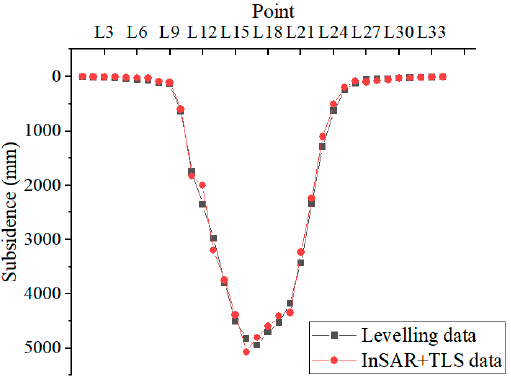
Figure 16. Comparison of levelling monitoring results and data fusion monitoring results. Table 7. Comparison of maximum subsidence values monitored by level data and fused data.